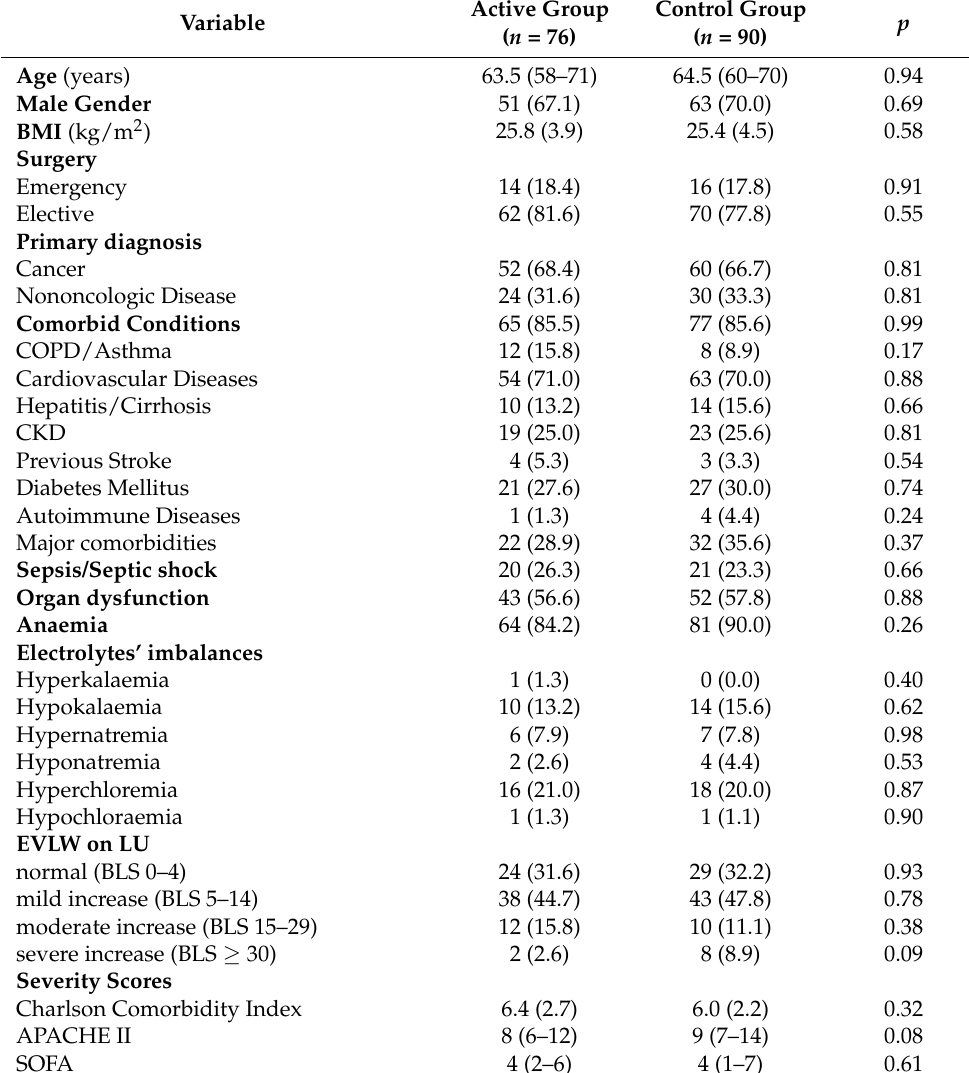
Table 2. Baseline characteristics of patients.